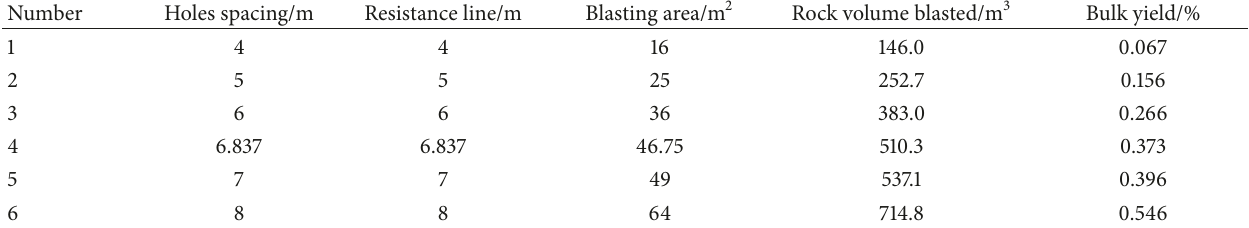
Table 6: The blasting quality of six perfectly square patterns.